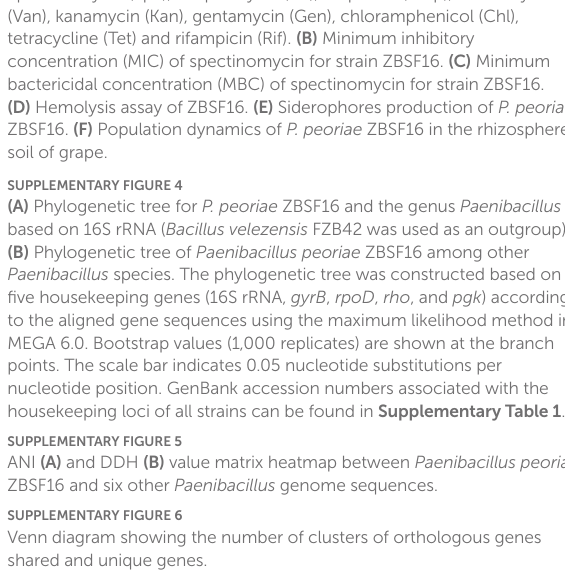
(F) Production of lipase. Determination of NaCl (G) and pH (H) tolerance capabilities of P. peoriae ZBSF16. SUPPLEMENTARY FIGURE 2 Antagonistic assay and biocontrol effect of Paenibacillus peoriae ZBSF16. (A) Colony radius and inhibition rate of each microorganism. Bars plot the means ± standard deviation of three replicate experiments. Coniella vitis (CV). Gloeosporium fructigrum (GF). Pestalotiopsis clavispora (Pc). Alternaria viticola (Av). Diaporthe eres (DE). Fusarium oxysporum (Fo). Botrytis cinerea (BC) . Botryosphaeria dothidea (BD). Aspergillus niger (AN). Fusarium graminearum (FG). Fusarium pseudograminearum (FP). Allorhizobium vitis (ALV). (B,C) Incidence, disease index and control efficiency of P. peoriae ZBSF16. (a1, b1) Inoculated with C. vitis ; (a2, b2) LB broth; (a3, b3) sterile water; (a4, b4) culture of ZBSF16; (a5, b5) inoculated with C. vitis 24 h after inoculation with the culture of ZBSF16; (a6, b6) inoculated culture of ZBSF16 24 h after inoculation with C. vitis . (D) Disease symptoms and growth state of Vitis vinifera (cv. Red globe) inoculated with strain ZBSF16. (E) The infection rate and disease index of grape white rot on Vitis vinifera (cv. Red globe) inoculated with strain ZBSF16. CK plants were treated with sterile water. Different letters above the bars denote a significant difference at p < 0.05 according to Duncan’s multi-range test. SUPPLEMENTARY FIGURE 3 Determination of antibiotic resistance of Paenibacillus peoriae ZBSF16.